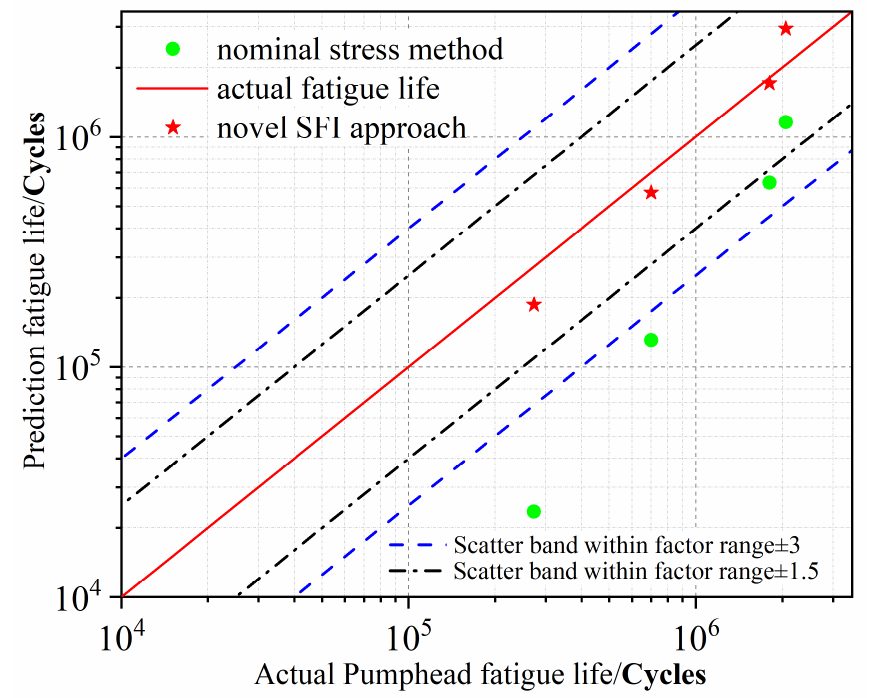
Figure 18. Pumphead fatigue life prediction accuracies of NSM and the novel SFI approach.